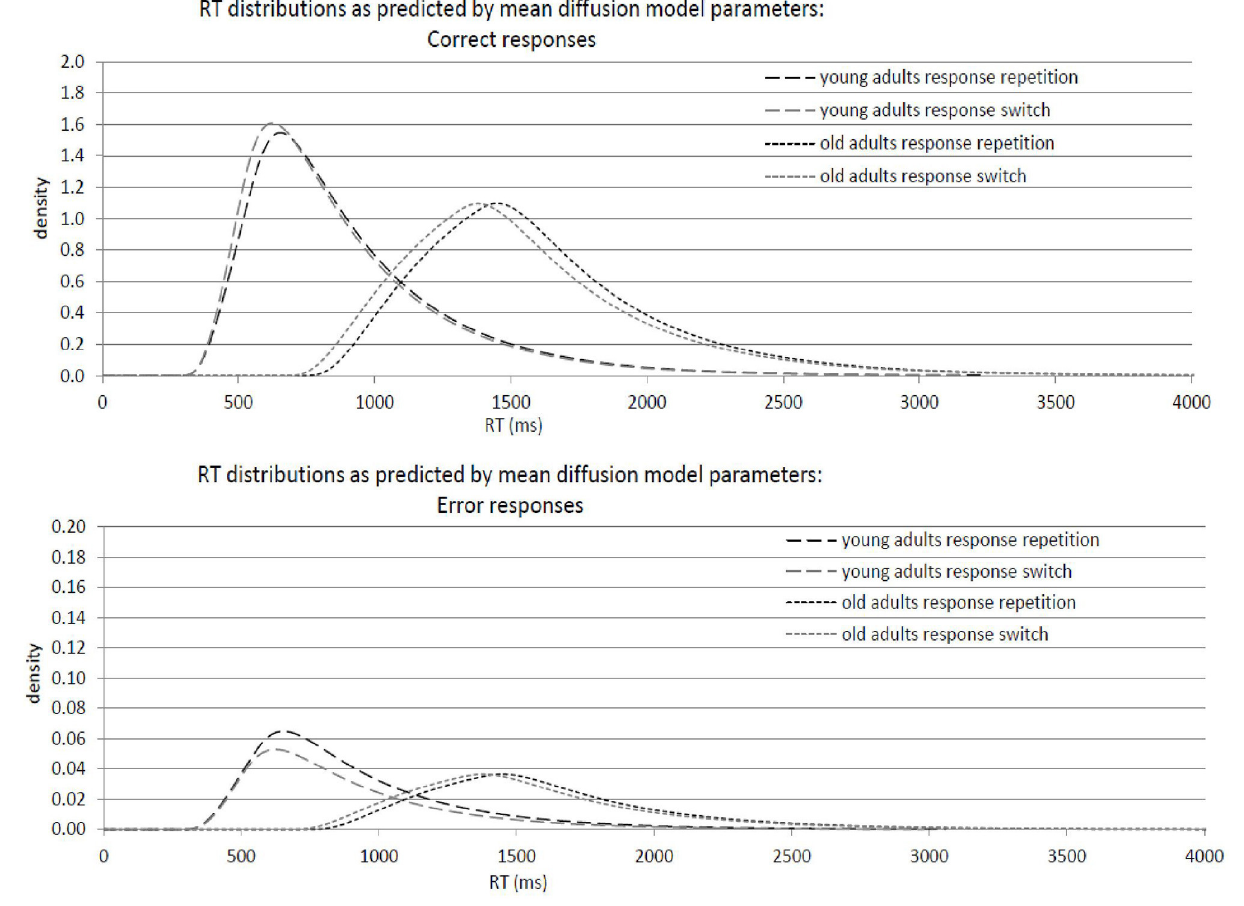
FIGURE 5 | Graphical illustration of response-time distributions resulting from mean diffusion model parameters in response repetitions and response switches in young adults (18–26 years; N = 22) and older adults (64–79 years; N = 22). Upper panel: Distribution of correct responses. Lower panel: Distribution of error